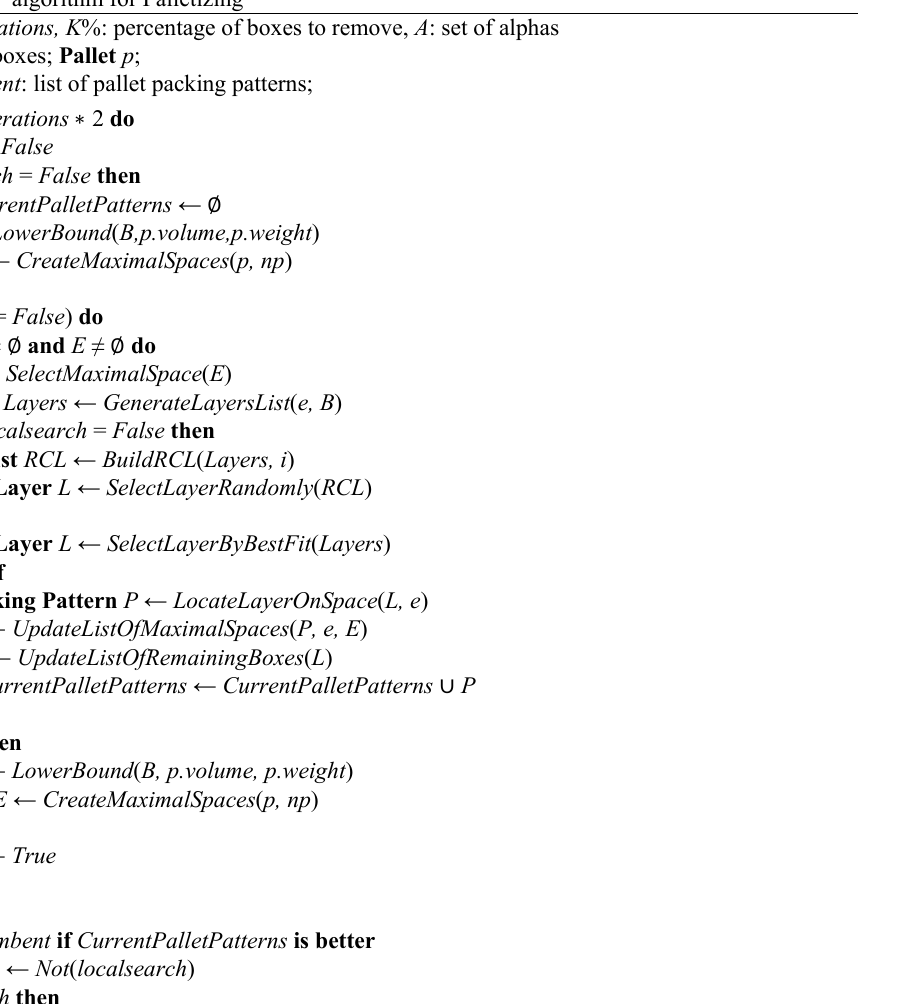
Algorithm 2 GRASP algorithm for